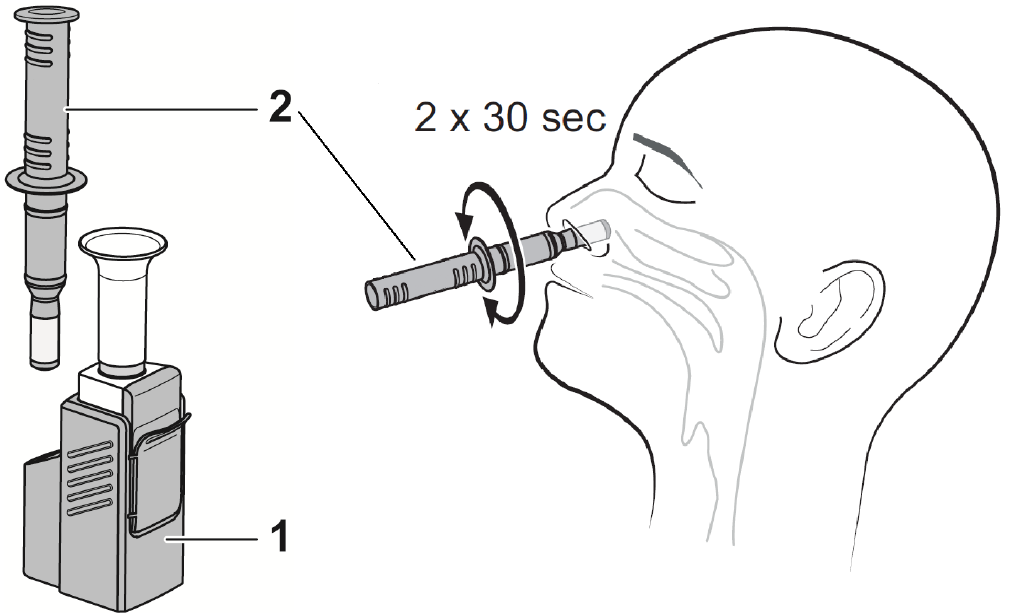
Figure 1. Sample collection-on the left, the test kit comprising a test cassette ( 1 ) and a removable sample collector ( 2 ) are shown. On the right, the sampling procedure is shown schematically.